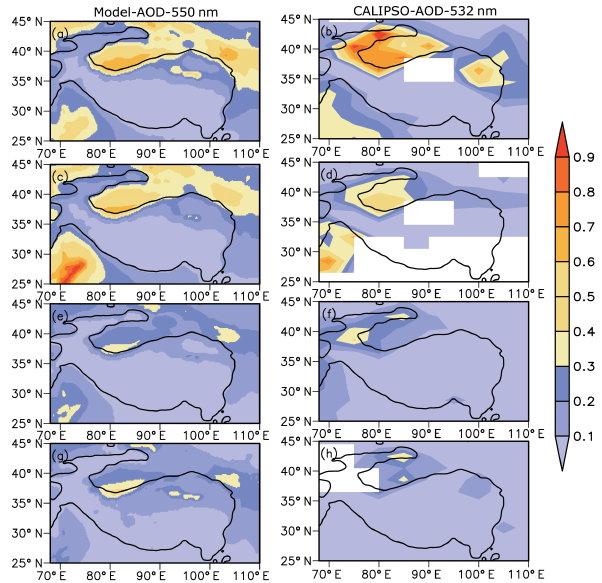
Figure 6. Spatial distribution of the dust AOD simulated by the control experiment (a, c, e, g) and the corresponding observed by CALIPSO (b, d, f, h) averaged in (a, b) spring, (c, d) summer, (e, f) autumn and (g, h) winter during the time period